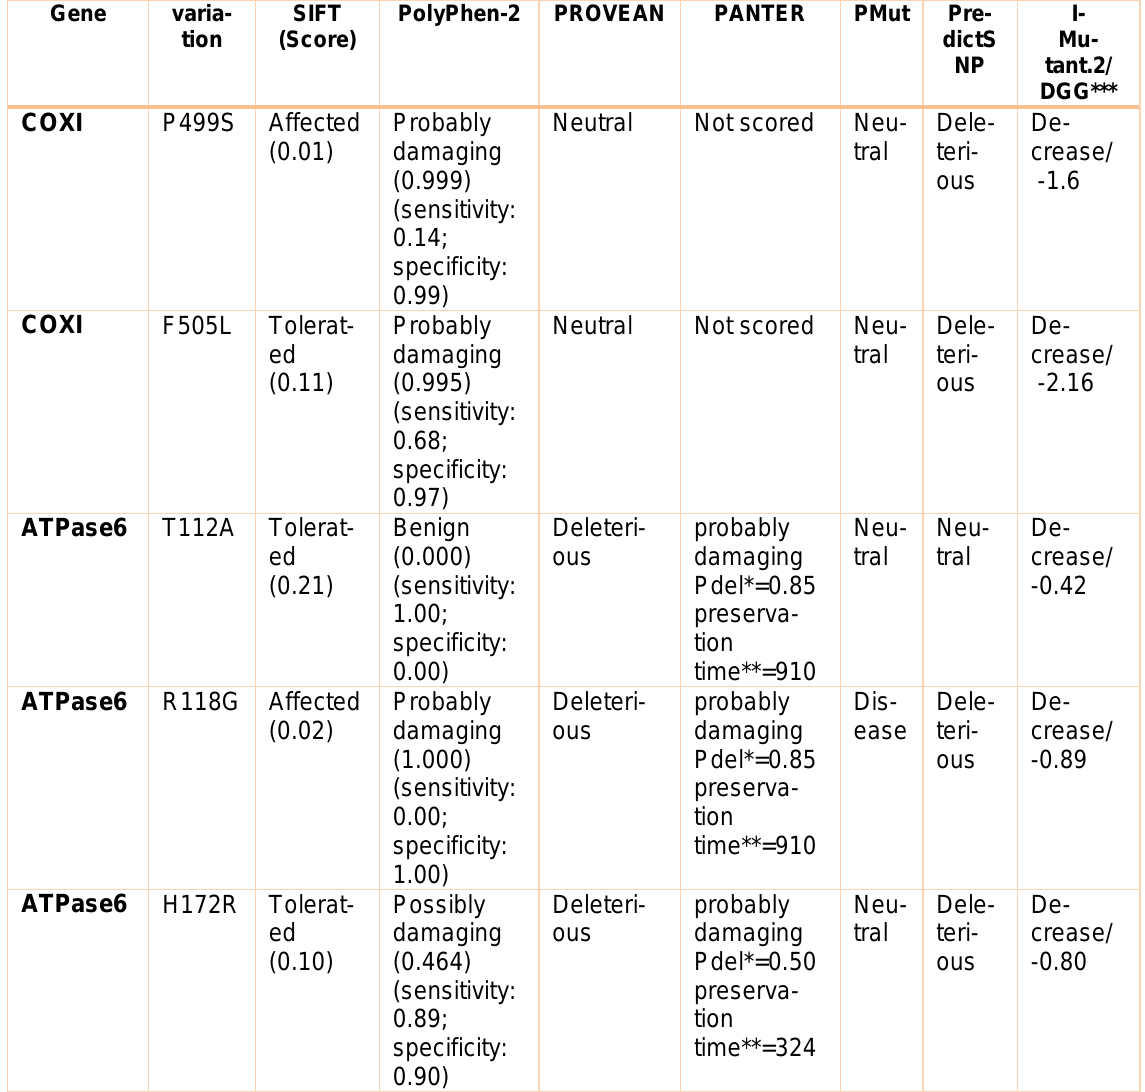
Table 4: Prediction results for 5 missense mutations in COXI and ATPase6 genes by functional and structural prediction